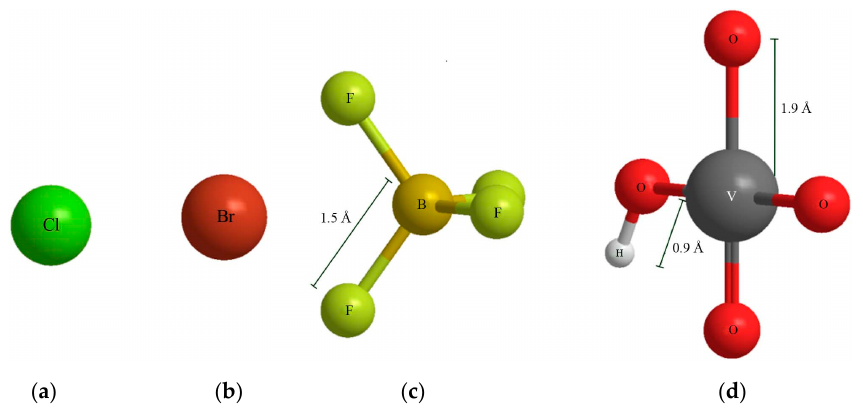
Figure 5. The ball-stick models of anions. ( a ) Cl − ;( b ) Br − ;( c ) BF 4 − ;( d ) HVO 42 − . It is observed from Figure 5 that the bond lengths of B-F and V-O were 1.5 Å and 1.9 Å, respectively. The V-O bond length was longer than B-F obviously. The radius of HVO 42 − was evaluated through the bond-additivity using a V-O bond length of 190 pm, V (V) ionic radius of 54 pm, and oxygen ion radius of 140 pm. The volume of HVO 42 − was calculated by ChemBioOffice2014 software. The radius and volume of anions are shown in Table 3. Table 3. The radius and volume of anions.